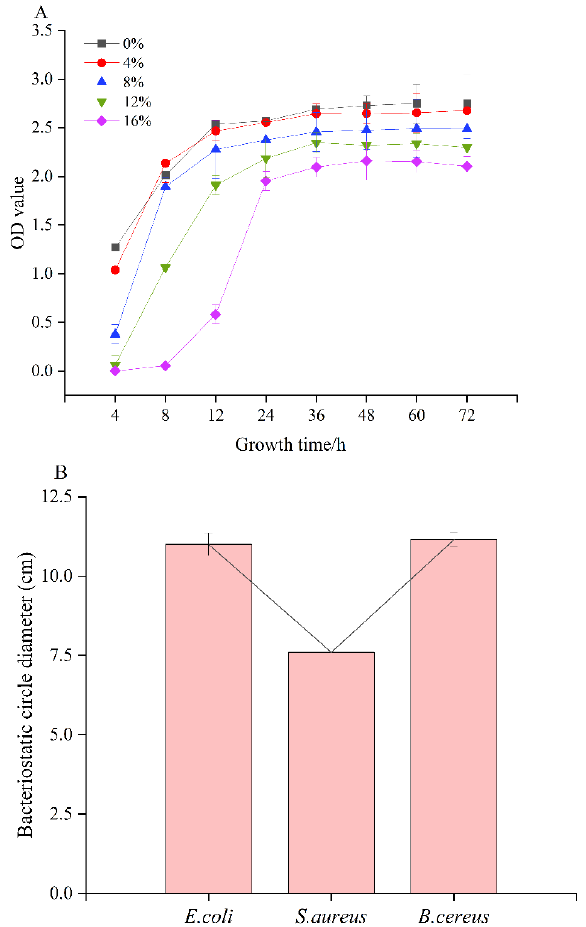
Figure 2. Salt tolerance ( A ) and antibacterial activity ( B ) of L. plantarum MMB-05.